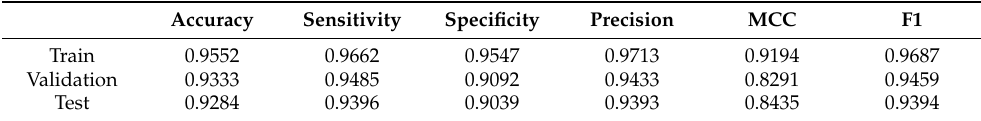
Table 1. The evaluation for classification